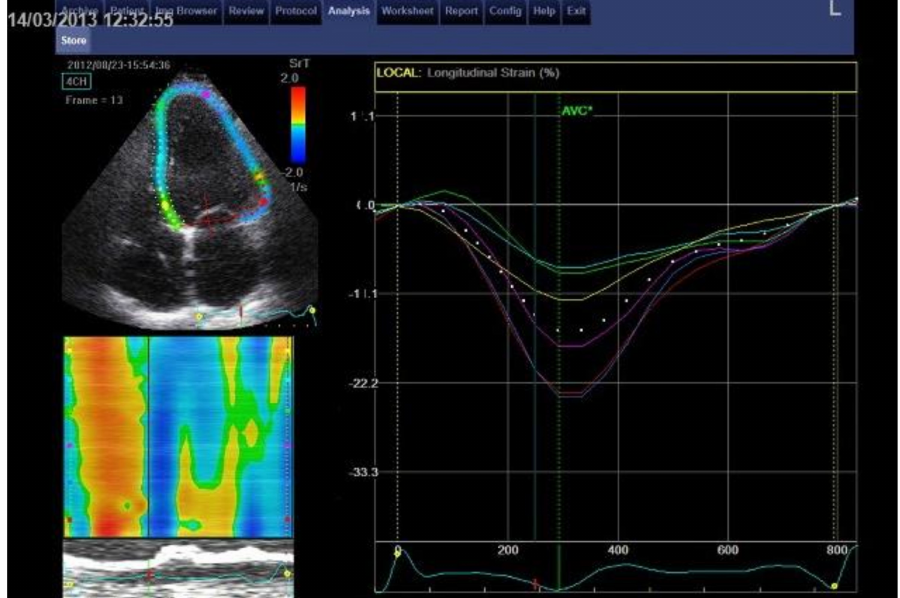
Figure 1. Speckle-tracking 2D-strain imaging (apical 4-chamber view). On the selected optimal image, the left ventricular (LV) endocardial border is manually traced on the end-diastolic frame and the software automatically draws the epicardial contour (left upper figure). The accuracy of the automated tracking of the cardiac outlines is assessed visually and is adjusted manually as required so that the region of interest (ROI) fits the LV wall thickness. ROIs are then subdivided into the standard segments (left upper figure). Thereupon longitudinal global strain (white dotted curve) and regional longitudinal strain curves (separate, coloured curves for each of the left ventricular wall segments seen in this view) are generated by the software (right